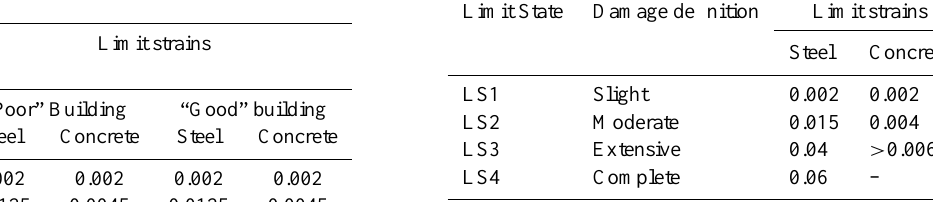
Fig. 8. Example of building stresses (in kPa) computed in the frame sections for different section ratios (SR), considering a horizontal loading displacement (0 ◦ ) with fixed magnitude (15cm). Table 1. Limit strain states suggested by Bird and co-workers, for reinforcement steel and concrete materials, considering poorly and well confined buildings (see Bird et al., 2005a).